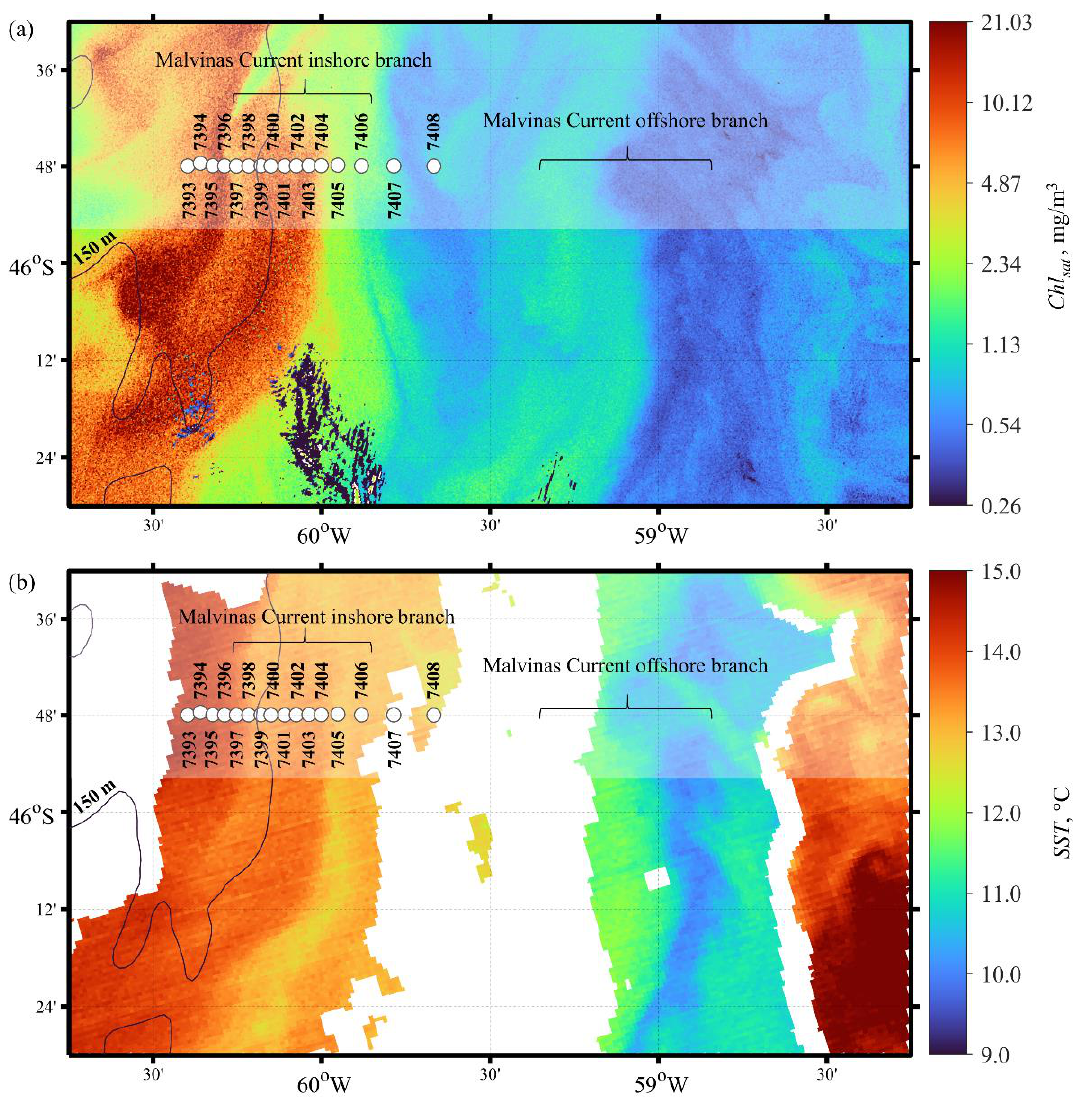
Figure 3. Satellite maps of chlorophyll- a concentration ( Chl sat ) obtained by OLCI/Sentinel-3B ( a ) and sea surface temperature ( SST ) obtained by VIIRS/SNPP ( b ) on 18 February 2022.